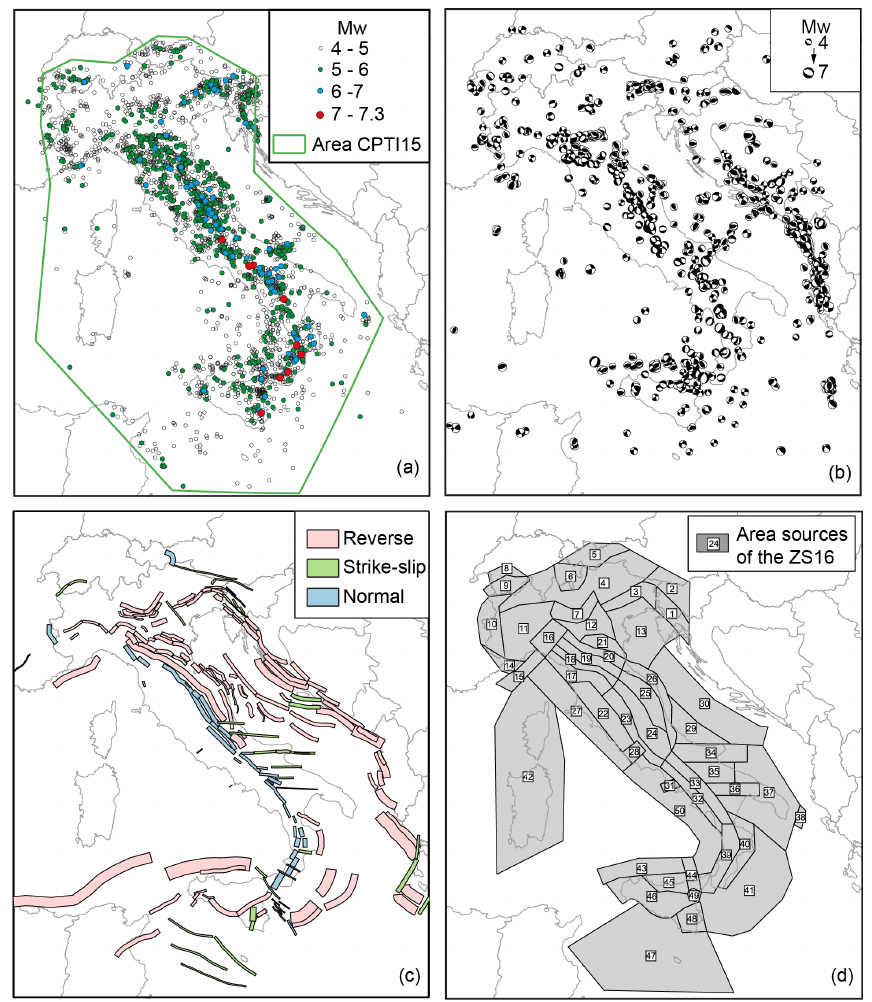
Figure 2. Main datasets (a, b, c) used to build the ZS16 (d) seismogenic zoning. (a) Earthquake epicentres from the CPTI15 catalogue (the green polygon represents the area covered by the CPTI15, as described by Rovida et al., 2016, 2020); (b) focal mechanisms of earthquakes with M w ≥ 4 (Pondrelli et al., 2020); (c) composite seismogenic sources from the DISS3.2.1 database (Basili et al., 2008; DISS Working Group, 2018); (d) seismogenic zoning ZS16 proposed in this